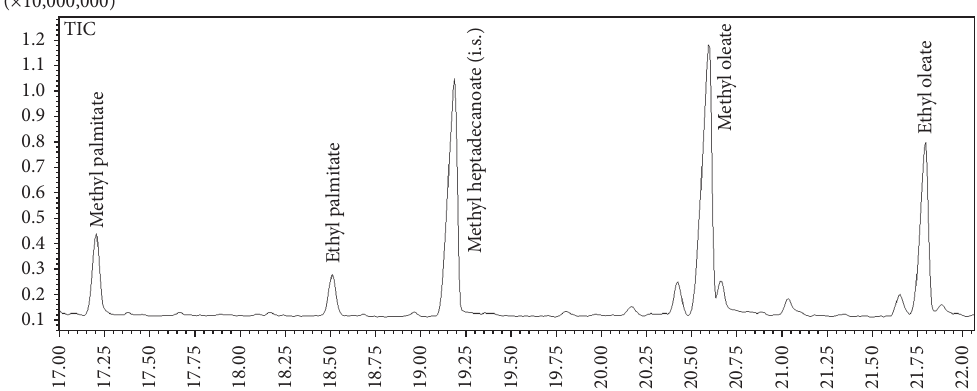
Figure 1: GC-MS profile of alkyl esters fraction from sample number 39 (Biancolilla variety, aged oil).